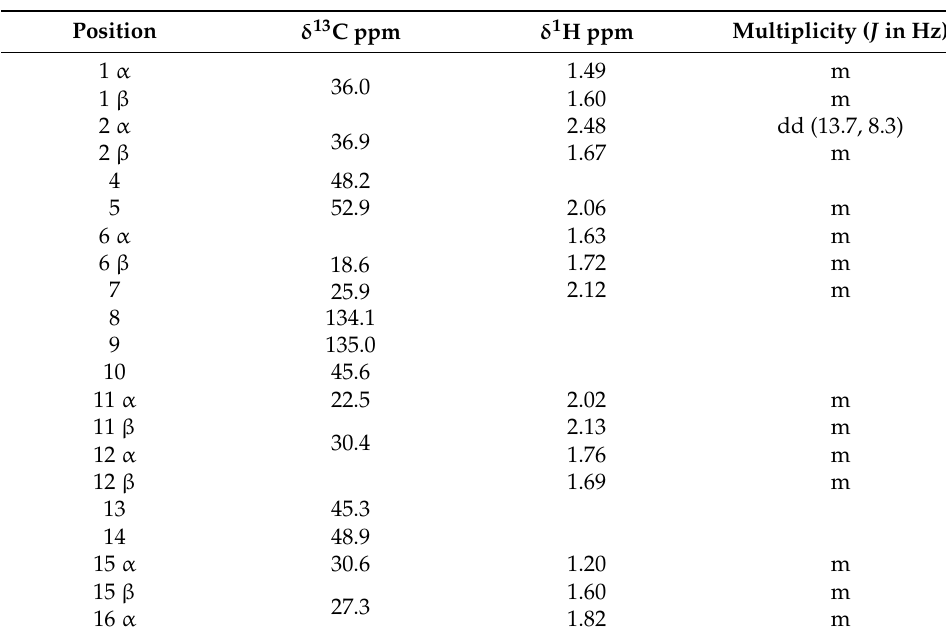
Figure 1. Compounds isolated from Fuscoporia torulosa ( 2 and 3 E - Z isomers). Table 1. 1 H- and 13 C-NMR assignments of